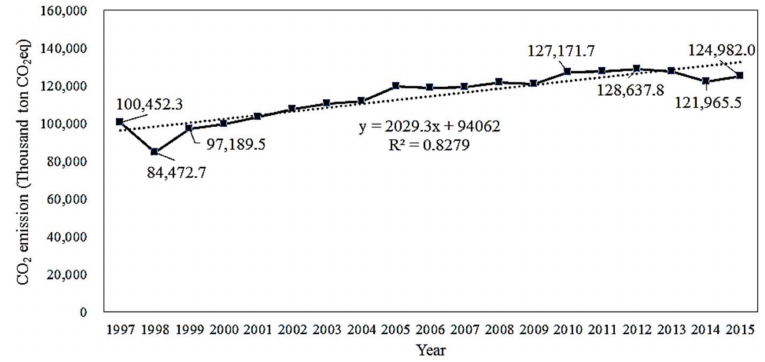
Figure 3. Greenhouse gas emission in buildings